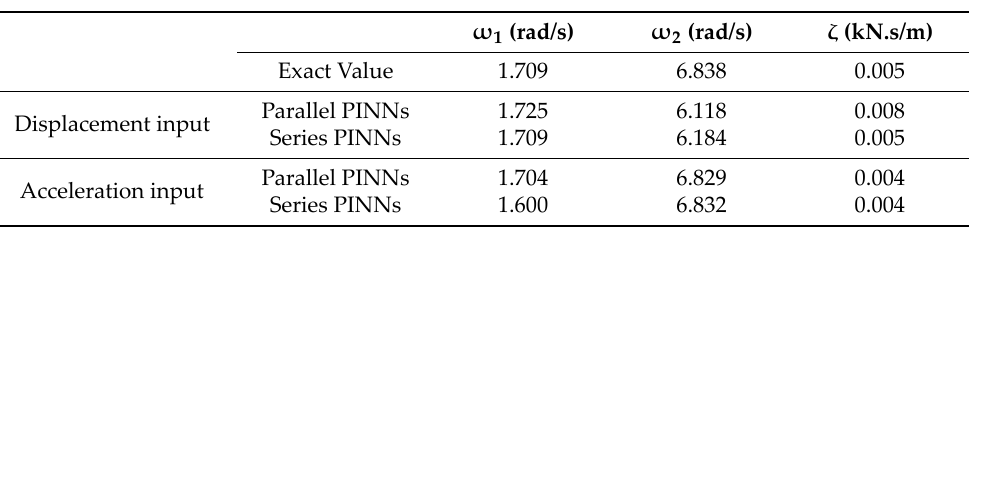
Figure 30. Parallel PINN estimations during the training period with displacement output.